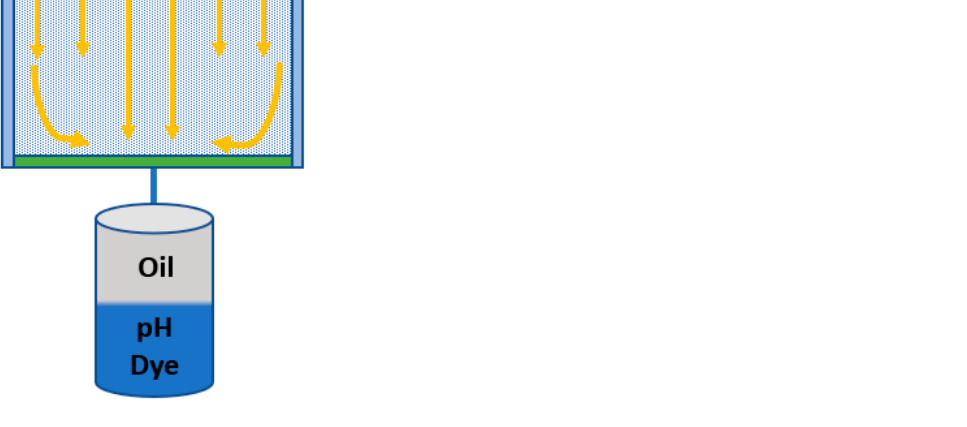
Figure 12. CO 2 transport speed (mm/min) as a function of Rayleigh number (Ra) for n -decane (this study) and for water [24] in 3-dim column experiments. In this kind of experiment, measurement/calculation of CO 2 mass transferred into the oil phase would be significant data. Due to the swelling of the oil phase, the CO 2 –oil boundary inside the vertical column moves upwards, as observed by Amarasinghe et al.